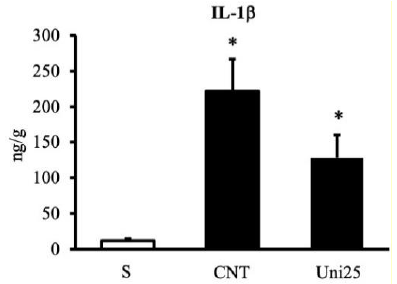
Figure 2. UniPR1331 attenuated TNBS-induced increase in IL-1β . IL-1β levels in colonic tissues excised from vehicle-treated normal mice (S) and TNBS-treated mice administered with vehicle (CNT) or UniPR1331 25 mg/kg (Uni25) ( n = 6–10 independent values per group). * p < 0.05 vs. S mice, Kruskal-Wallis test followed by Dunn’s post-test.